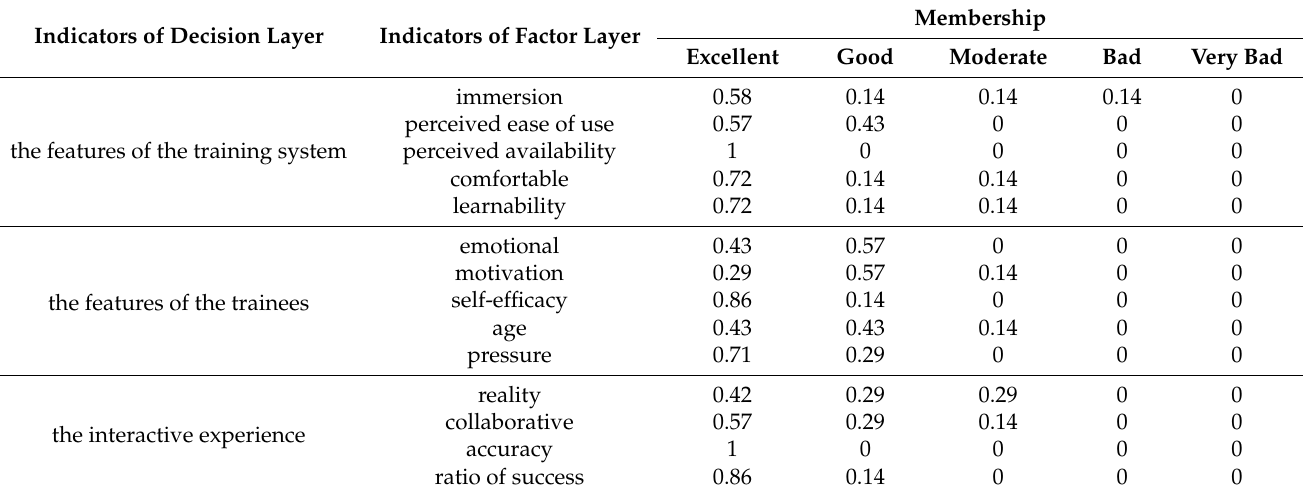
Table 6. The fuzzy evaluation membership matrix of MR seismic retrofitting training system. Indicators of Decision Layer Indicators of Factor